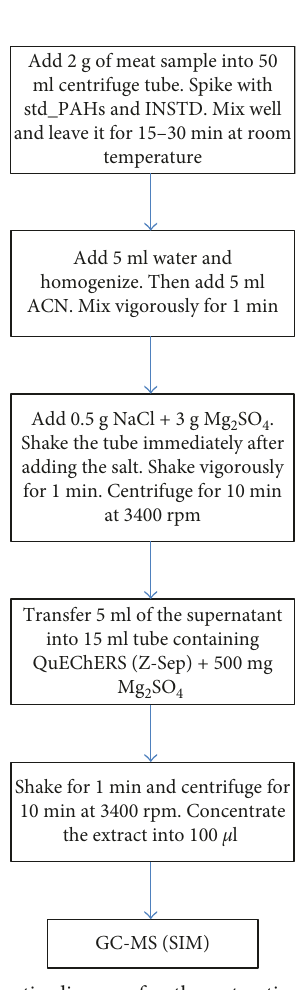
Figure 1: Schematic diagram for the extraction and cleanup of meat using QuEhERS